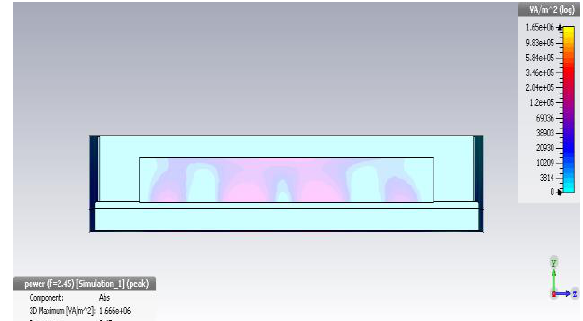
Fig. 3. The distribution of the electromagnetic field in the thickness of the processed substance.